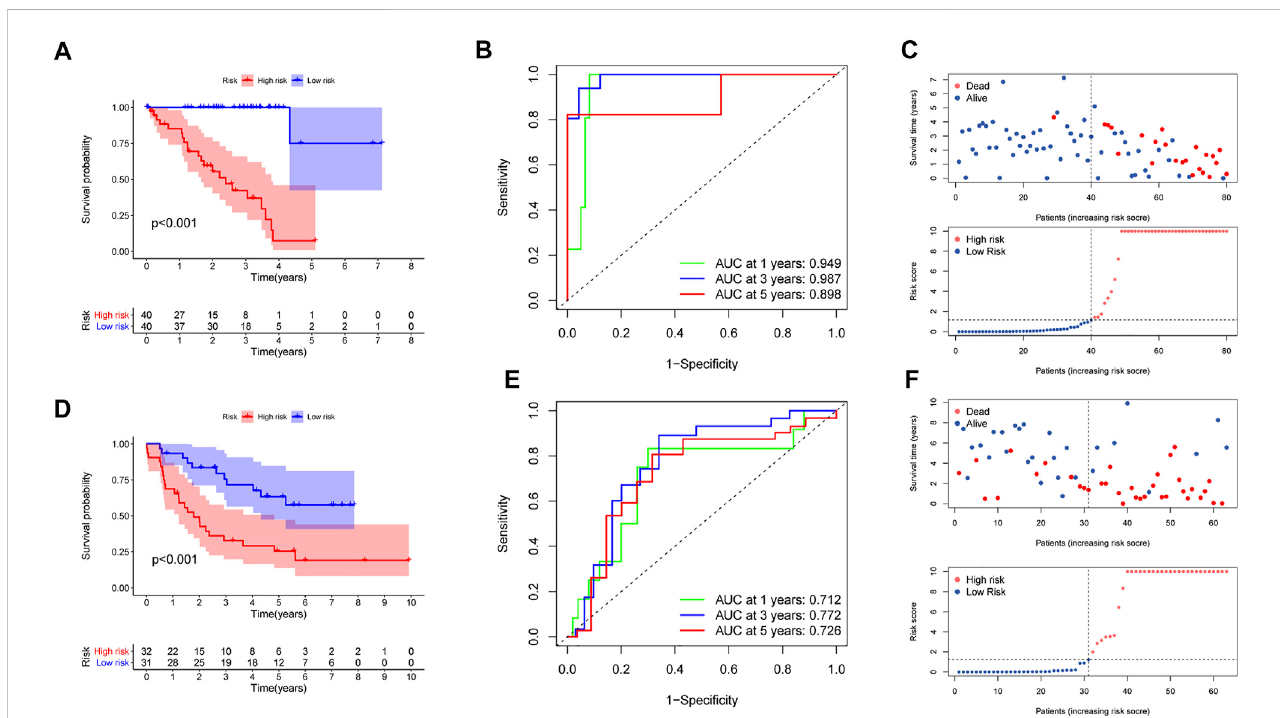
FIGURE 4 Evaluation of the MAGs-based score system. (A,D) Survival analysis for patients in the two subgroups. (B,E) ROC curves displayed the favorable ability of the model. (C,F) Distribution of the risk score and survival